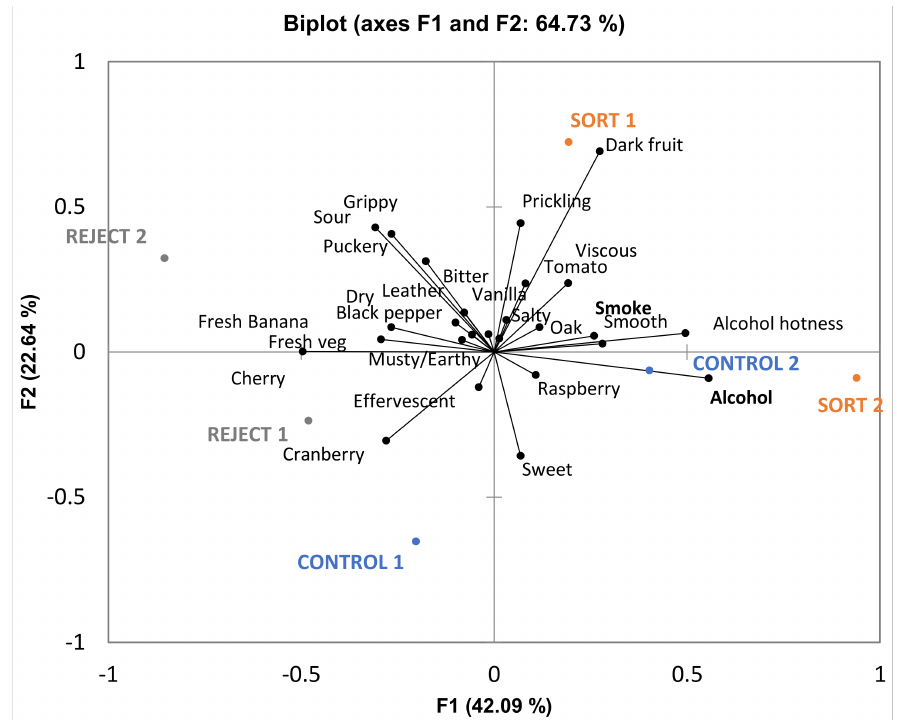
Figure 5. Biplot PCA of Barbera wines generated by descriptive sensory analysis. Significant attributes are given in bold ( n = 10, p <